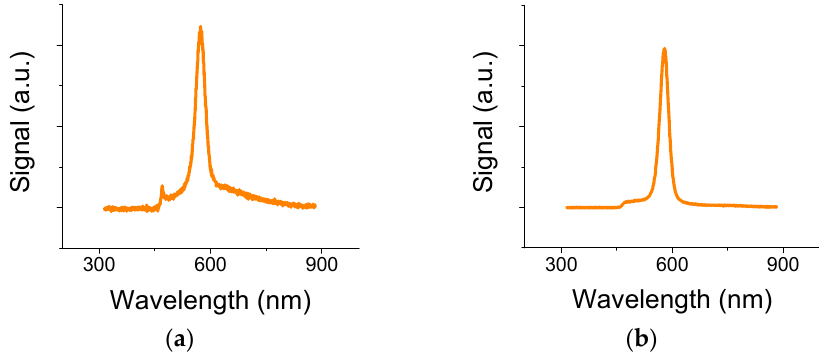
Figure 2. Full fluorescence curves for ( a ) sample S7 with 10 nm hafnia and ( b ) sample S2 without it. A laser cutoff filter was placed at 450 nm.